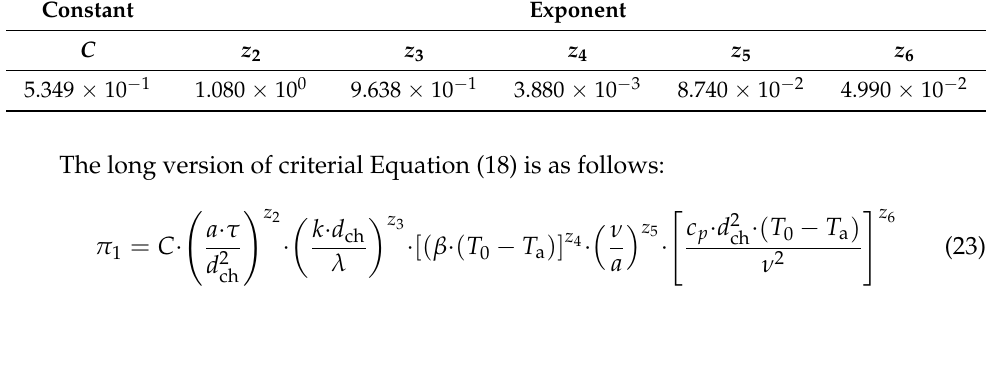
Table 2. Parameters of the regression function.